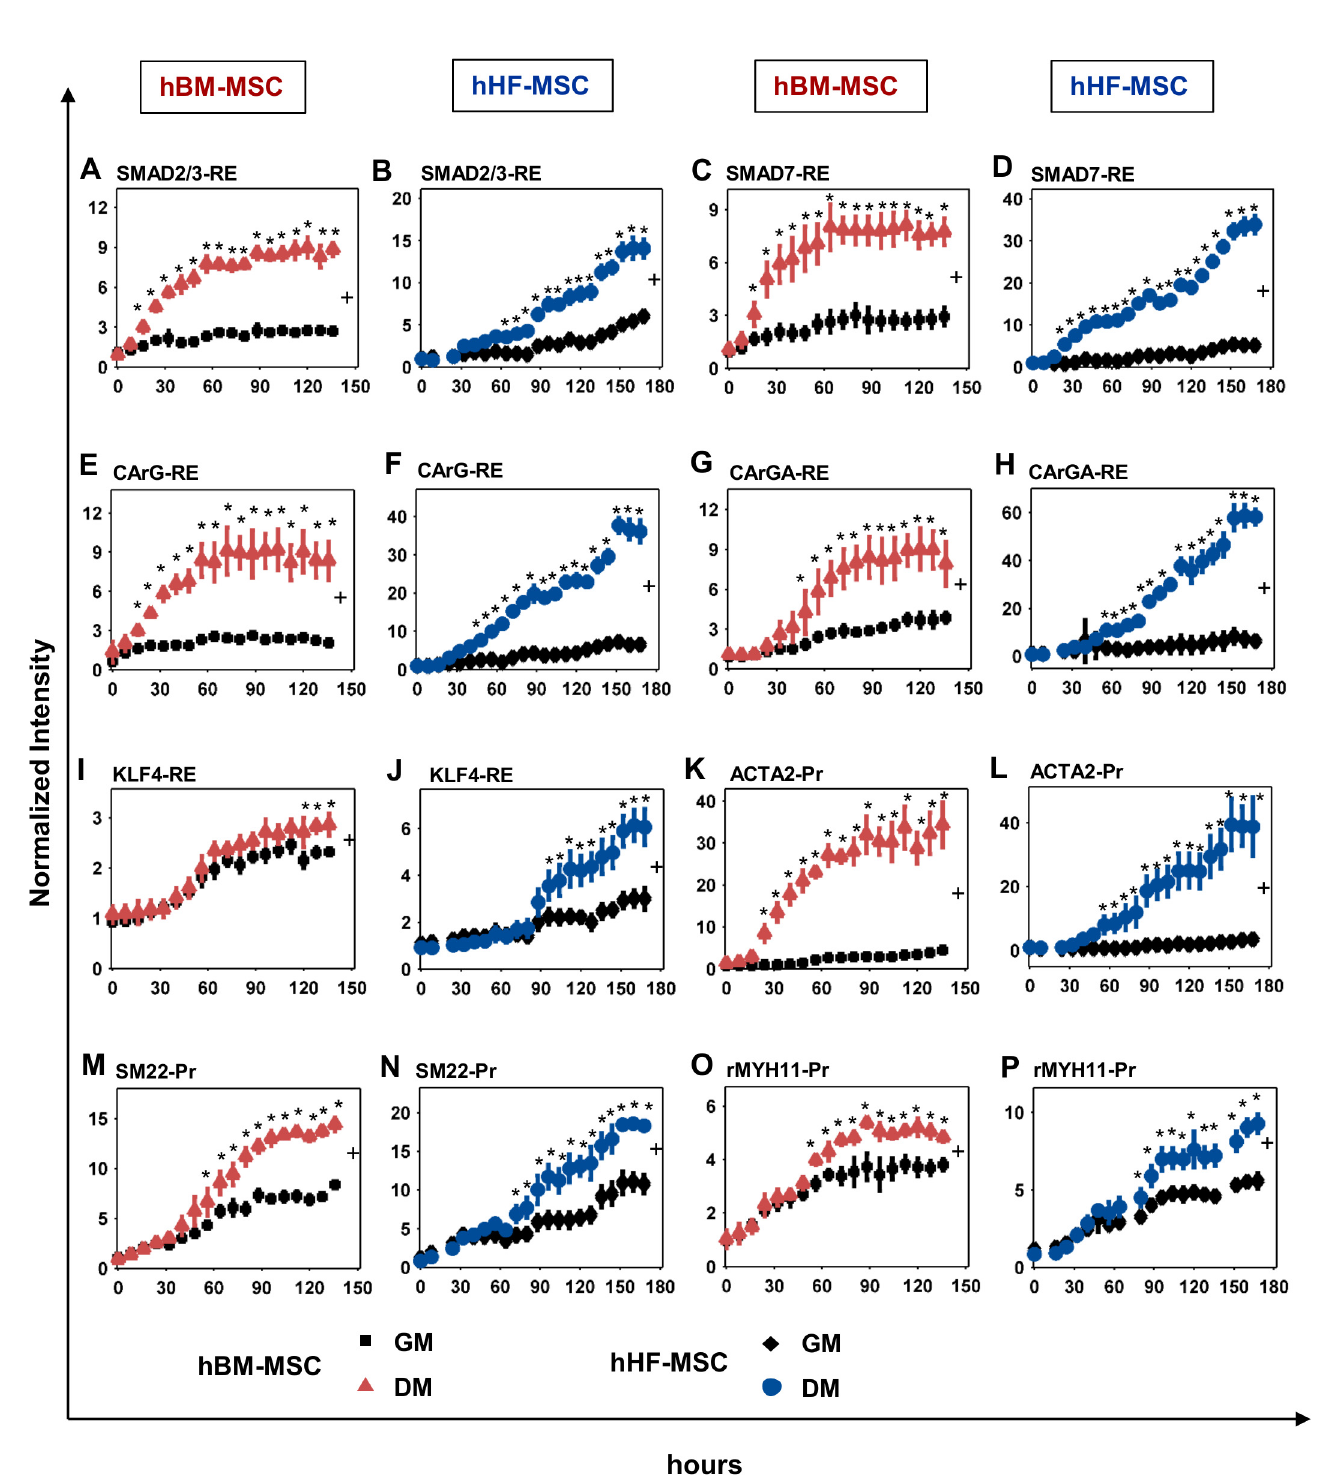
Fig 5. Dynamic response of Pr/RE in MSCs during Myogenic Differentiation. (A, C, E, G, I, K, M, O) hBM-MSCs or (B, D, F, H, J, L, N, P) hHF-MSCs were transduced with the LV library of 27 Pr/RE and coaxed to differentiate into SMCs. The activities of the (A, B) SMAD2/3-RE; (C, D) SMAD7-RE; (E, F) CArG-RE; (G, H) CArGA-RE; (I, J) KLF4-RE; (K, L) ACTA2-Pr; (M, N) SM22-Pr; and (O, P) rMYH11-Pr were determined by fluorescence microscopy and the